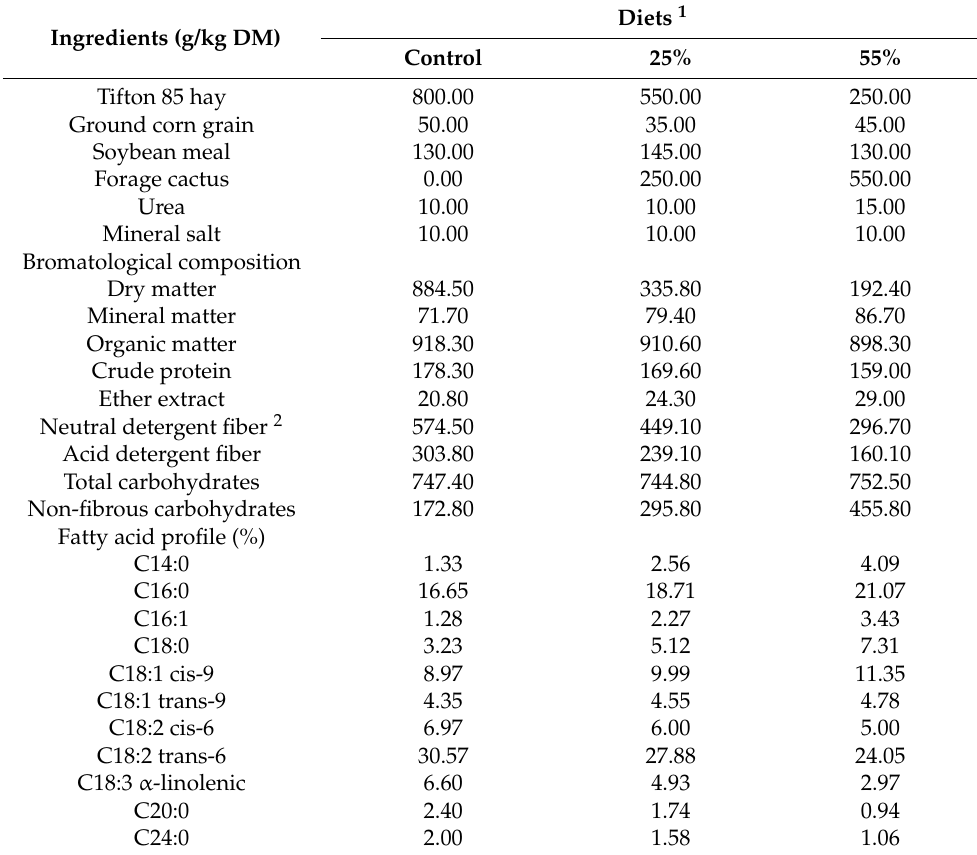
Table 2. Ingredients and chemical composition and fatty acid profile of experimental diets in a dry matter